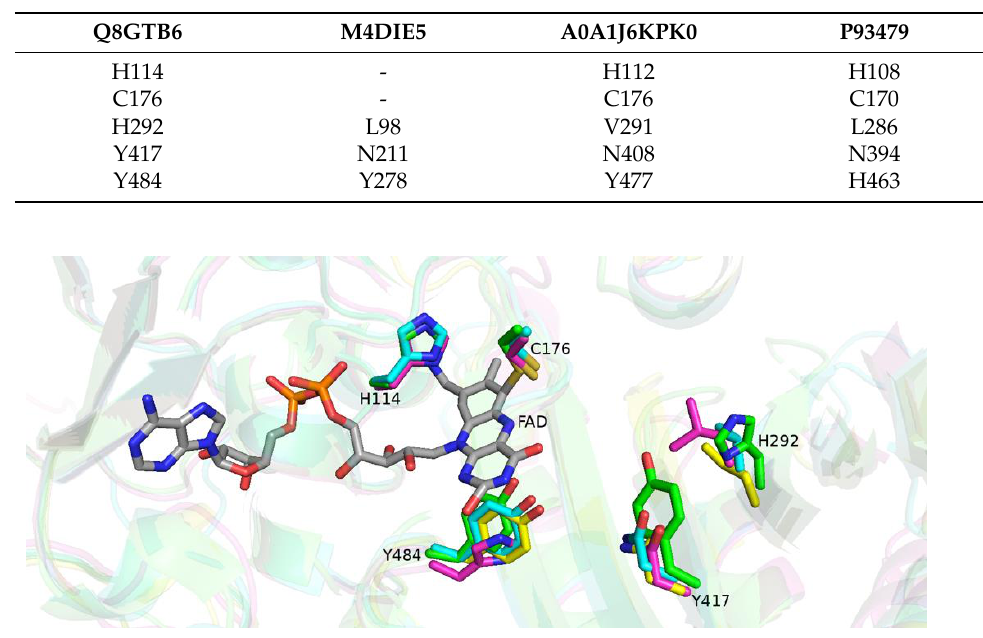
Figure 2. Alignment of critical residues in THCA synthase and the